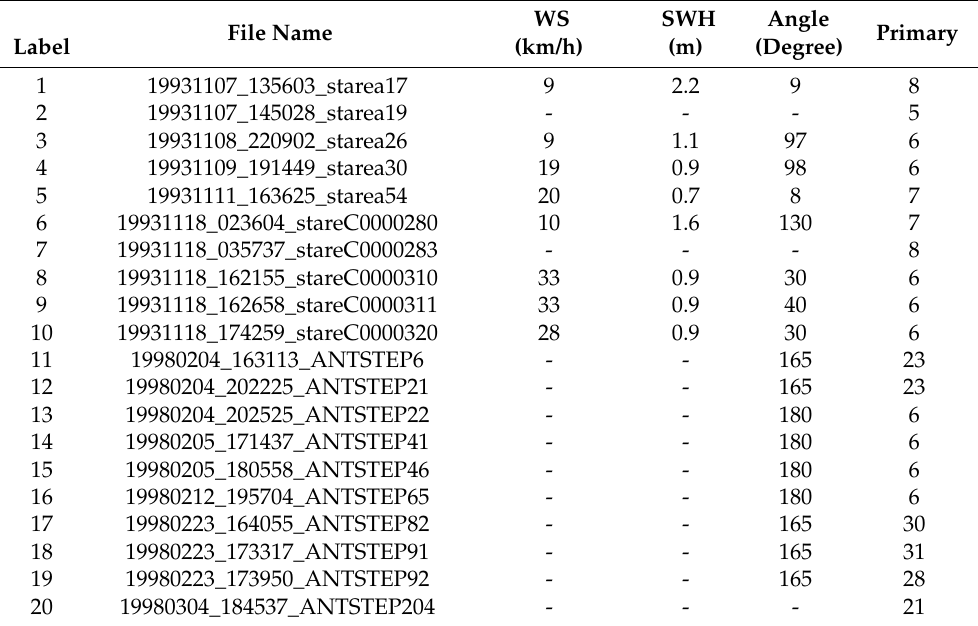
Table 1. Descriptions of the datasets of the IPIX radar